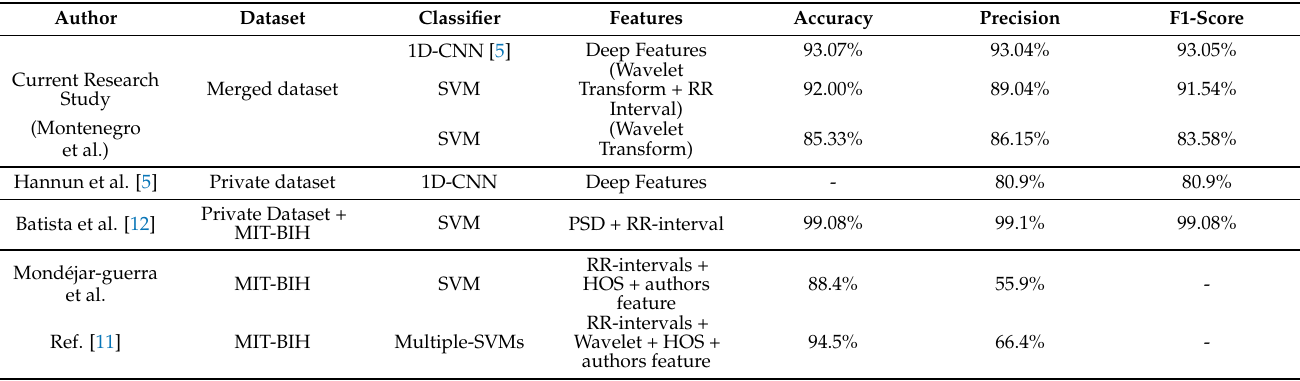
Table 6. Results of our study compared with previous studies based on state-of-the-art algorithms. It should be noted that each study used a different dataset, and it is the first time that the merged dataset is being used to classify cardiac